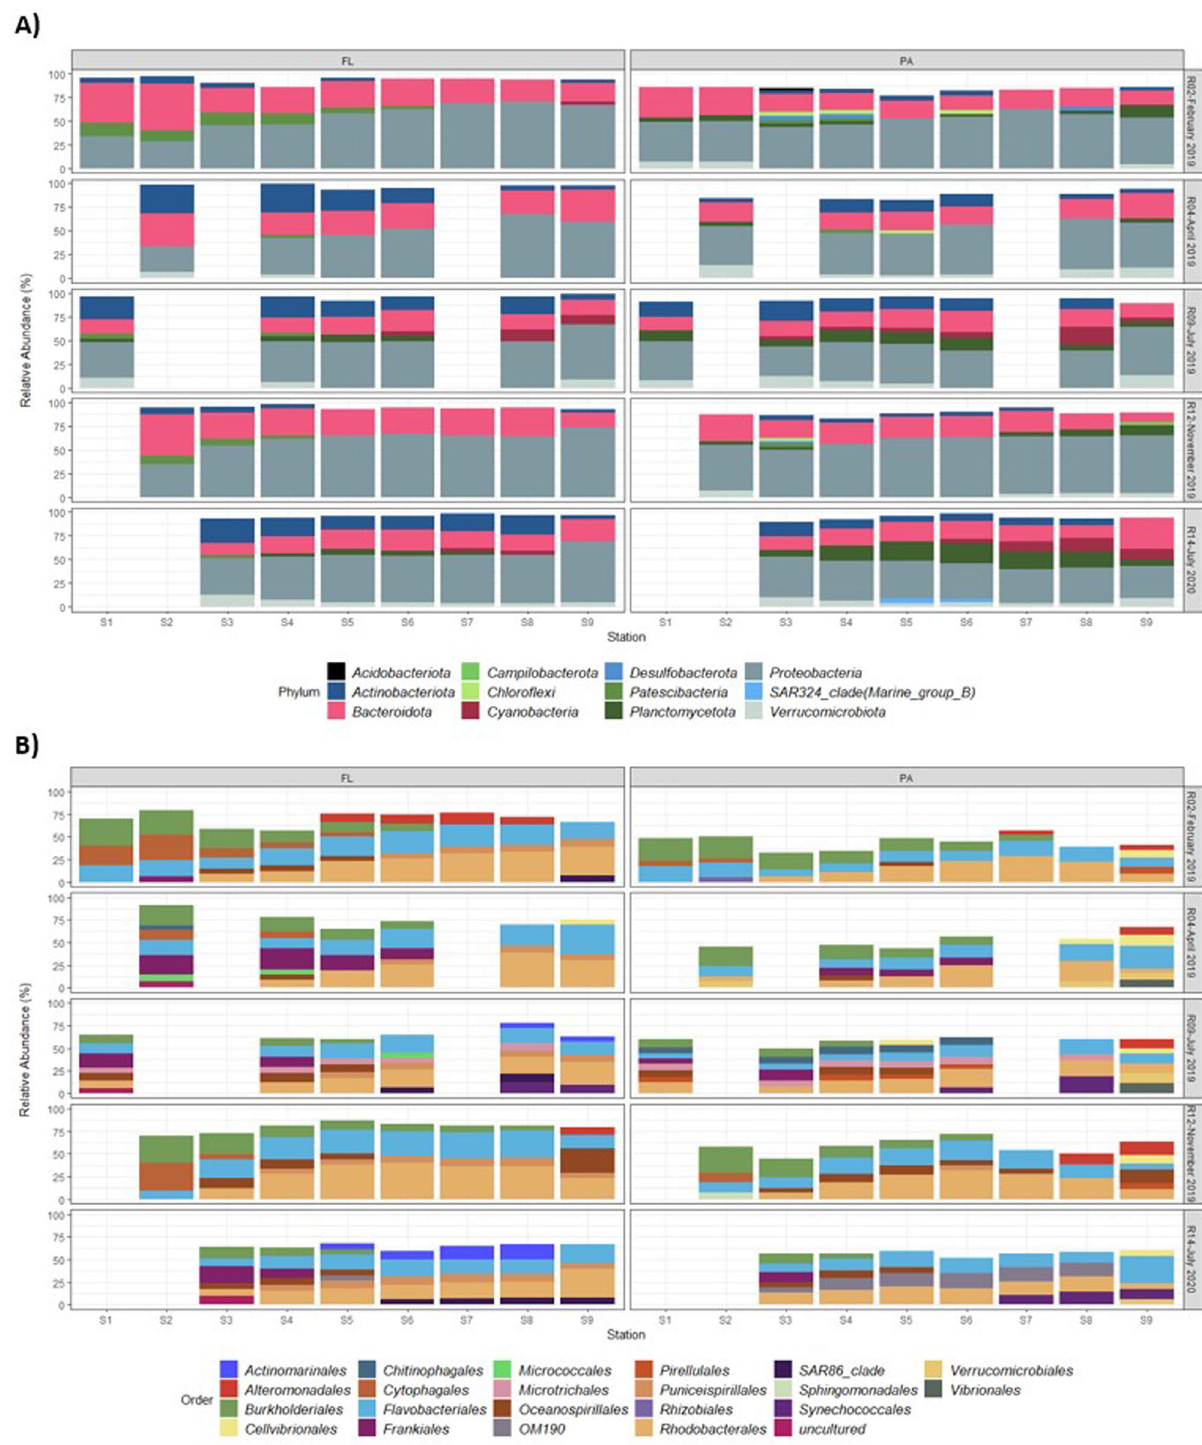
Figure 3. Bar plots showing the taxonomic composition of the FL and PA bacterial communities, aggregated at the phylum ( A ) or order ( B ) rank. Only the groups representing more than 3% (phylum) or 5% (order) within a sample are represented for